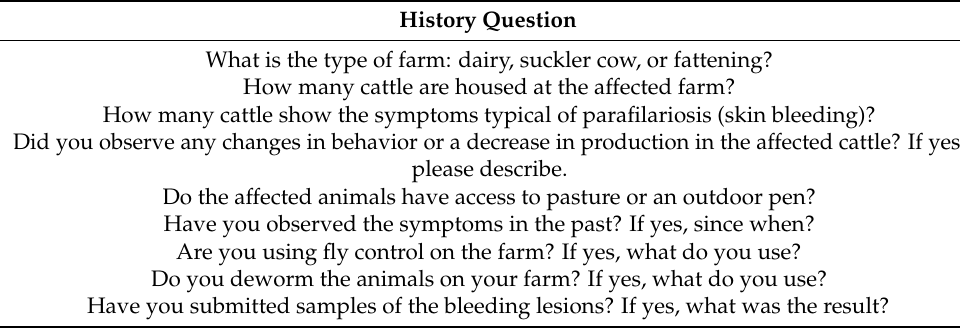
Table 1. History questions for farmers as distributed through